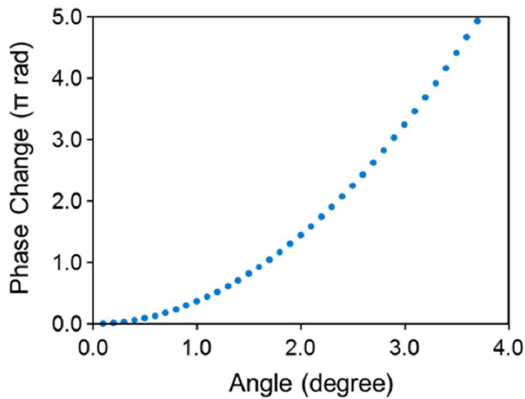
Figure 8. Dependence of the angle of CaF 2 plate on the phase change.